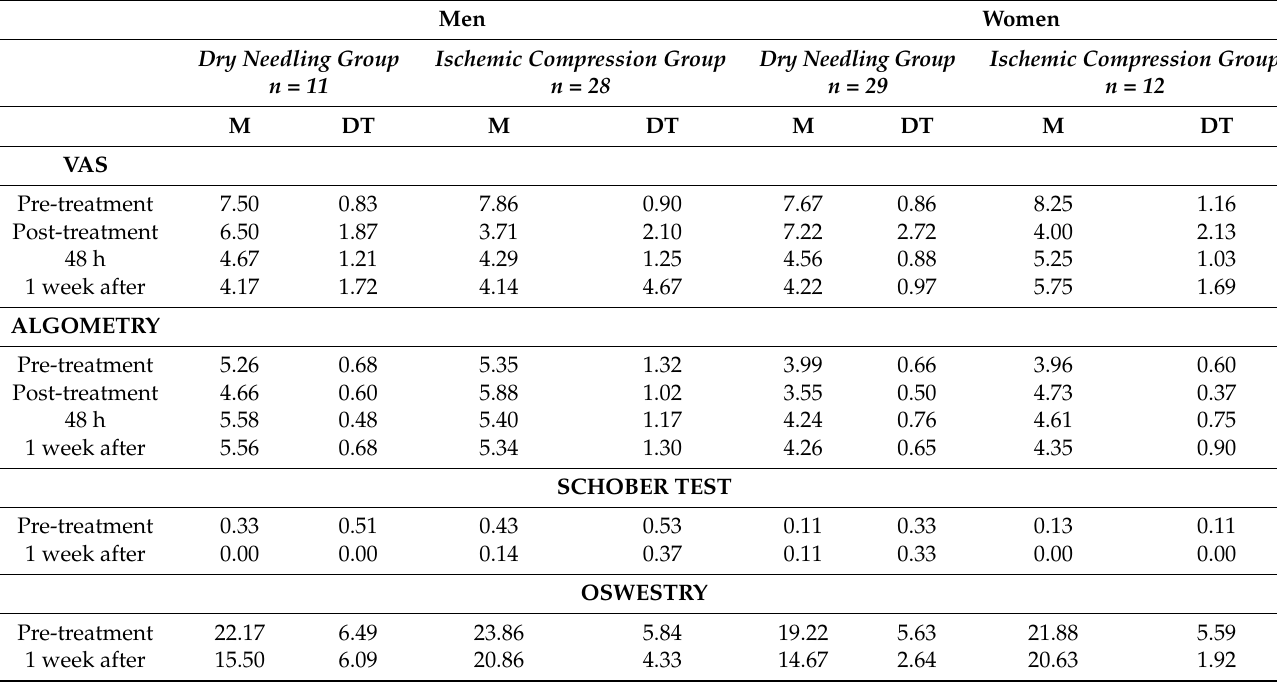
Table 3. Mean (M) and standard deviation (SD) of the dependent variables, by gender, group, and time of sampling.